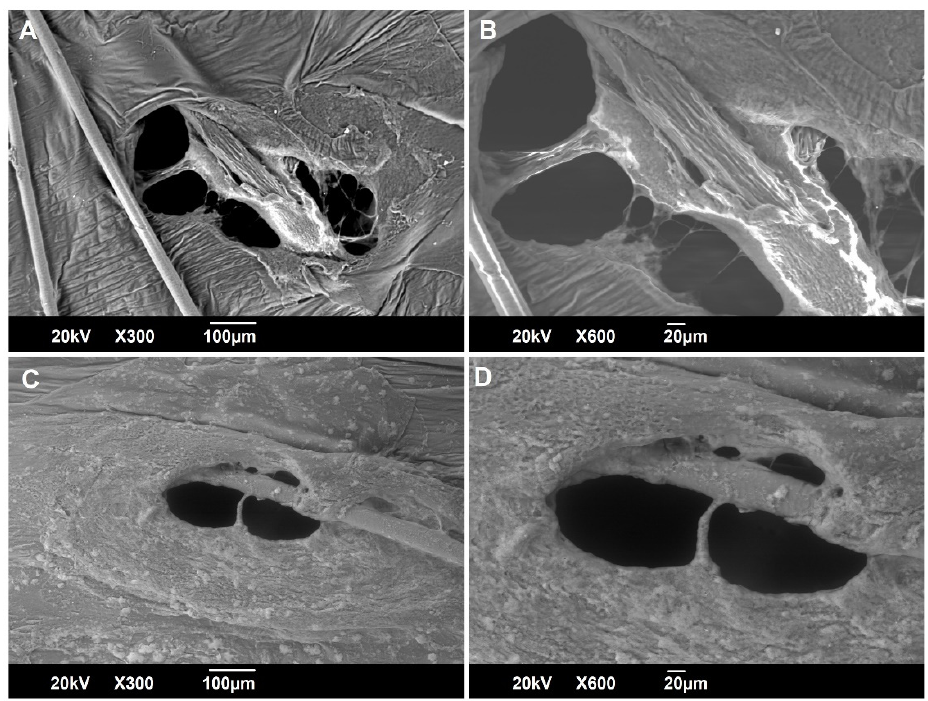
Figure 6. Scanning electron microscopy analysis of newborn pig skin after the jet injection of a DCF sodium solution ( A , B ) or DCF NS (pH 6.0) ( C , D ). Table 2. DCF recovered on the skin surface, within the skin or below the skin (vial) after jet injection of a DCF sodium solution or DCF NS (pH 6.0) across a skin specimen. Values are expressed as the percentage of the DCF dose injected. Results are the average of n = 3 independent